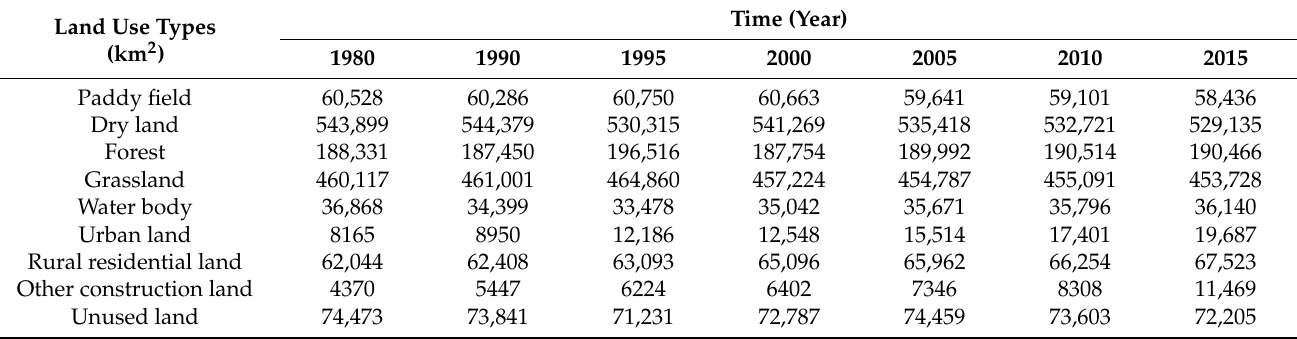
Table 2. The areas of various land use types in the Huang-Huai-Hai River Basin from 1980 to